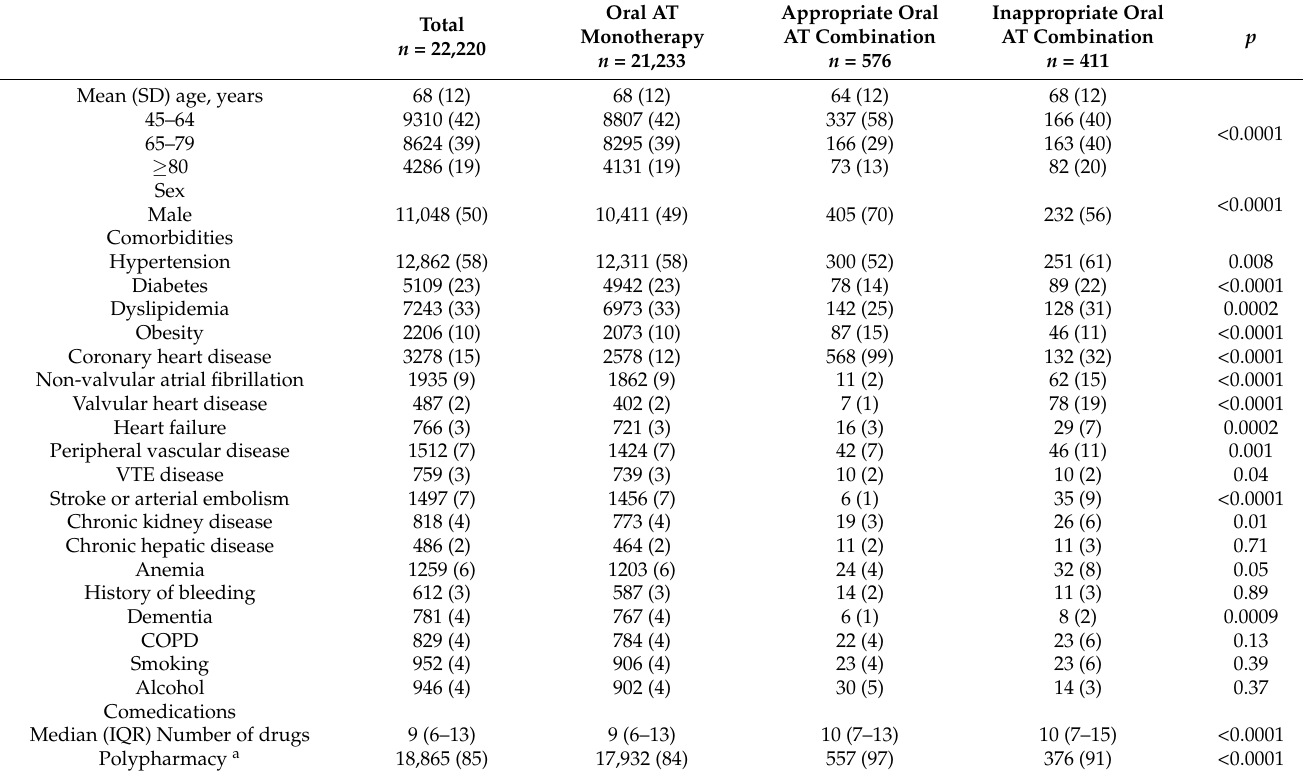
Table 1. Baseline characteristics of individuals: overall ( n = 22,220), with oral antithrombotic (AT) monotherapy ( n = 21,233), an appropriate oral AT combination ( n = 576) or an inappropriate oral AT combination ( n = 411) at study entry. Values are number (percentages) unless stated